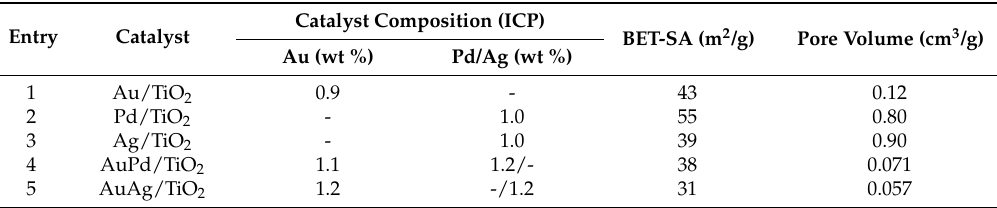
Table 1. BET surface areas and inductively coupled plasma (ICP) results of Au ‐ bimetallic (1 wt % each) catalysts over TiO 2 (anatase).